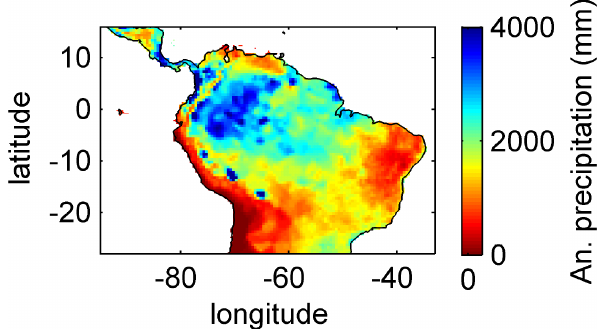
Figure B1. Mean annual precipitation for 2001–2010 under CRU climate input.